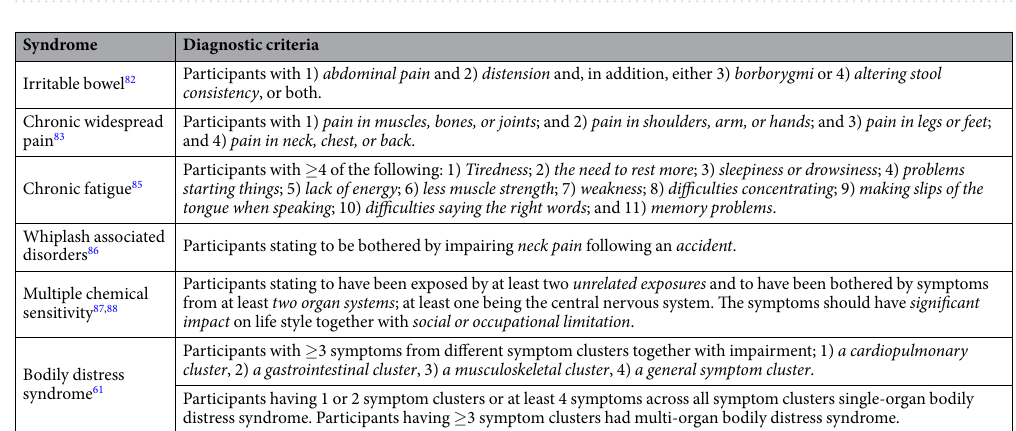
Figure 2. Flow of study participants.